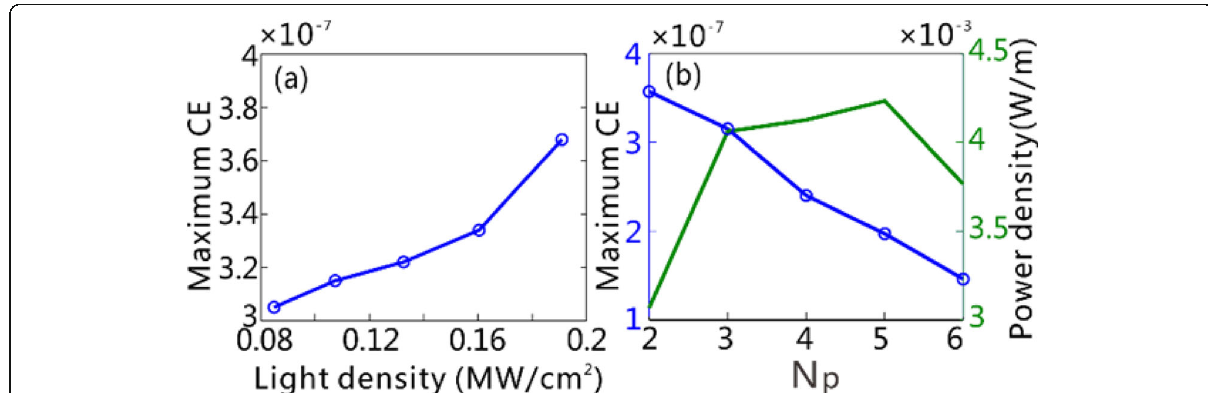
Fig. 6 a The maximum CE of THG as a function of the incident power density for N p = 3. b The maximum CE and the maximum output power density of THG as a function of the number of grating periods N p used, respectively. The incident power density is fixed at 0.11 MW/cm